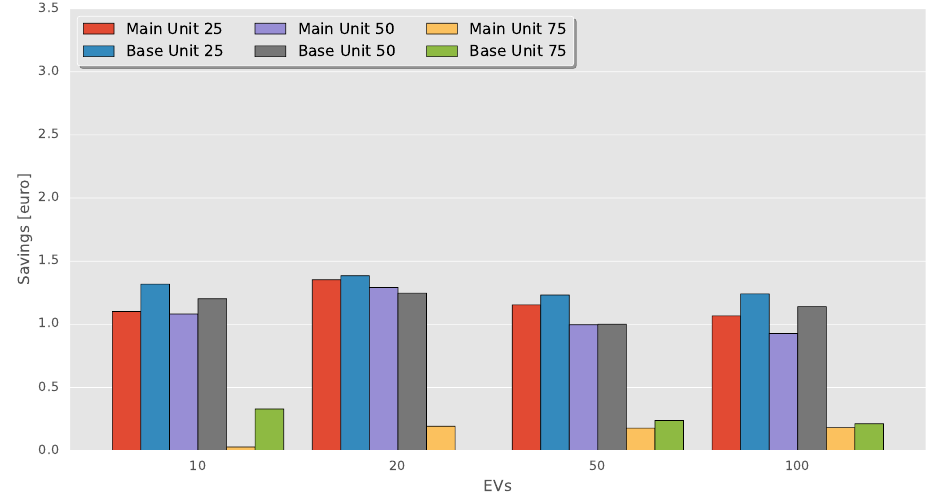
Figure 6. Average daily savings with trading units of 25, 50 and 75kW compared to a trading unit of 100kW.